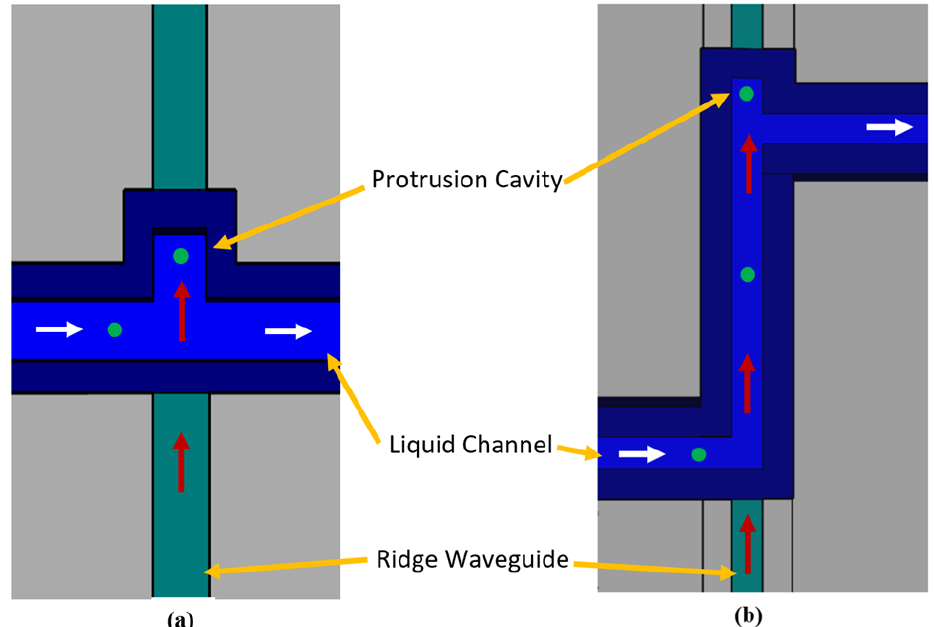
Figure 1. Optofluidic particle trapping for the orthogonal force ( a ) and gradient force ( b ) designs. Radiation pressure is shown by red arrows, fluid flow by white arrows, and green circles represent particles. The ridge waveguide, as shown by the green channel, couples light from a laser source off chip into the liquid channel where radiation pressure is used to push particles into the protrusion cavity. The protrusion cavity offers a physical mechanism to isolate the particles from the liquid